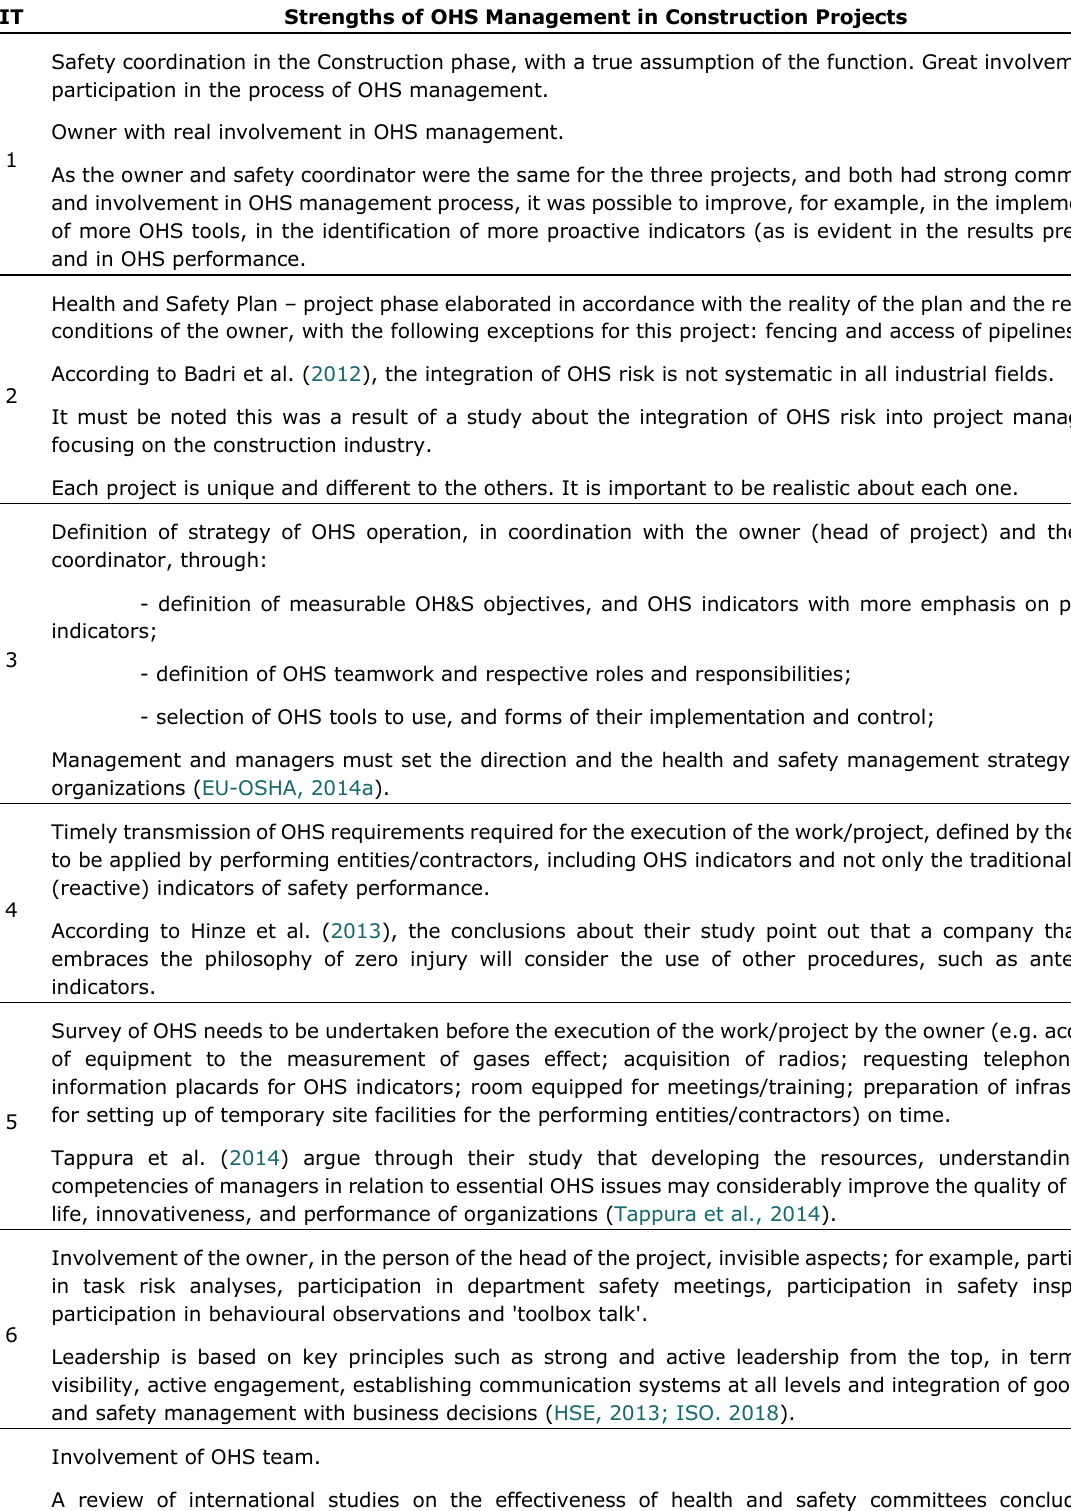
Table 3. Strengths of OHS Management in Construction